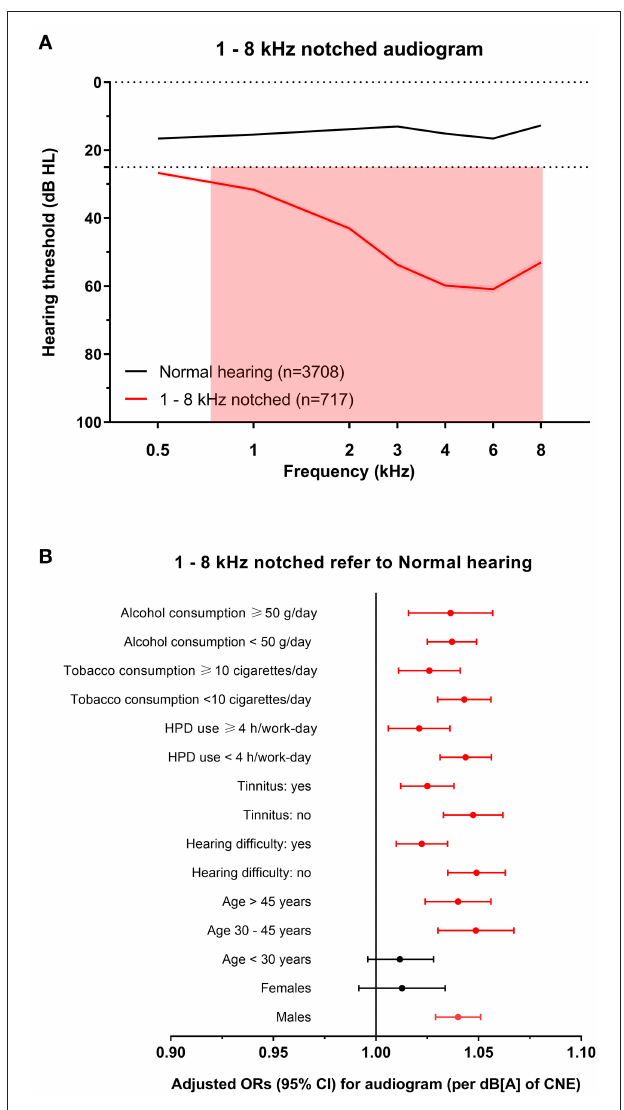
FIGURE 6 | The 1–8kHz notched audiogram and its association with noise exposure. (A) The average hearing thresholds over 0.5–8kHz frequencies of subjects with normal hearing and the cluster of 1–8kHz notched audiogram. The pink shade includes the range of notched frequencies. (B) Adjusted ORs with 95% CI of CNE increment (per dB[A]) for the 1–8kHz notched audiogram refer to normal hearing audiogram after stratification of sex, age, hearing difficulty, tinnitus, HPD use, tobacco consumption, and alcohol